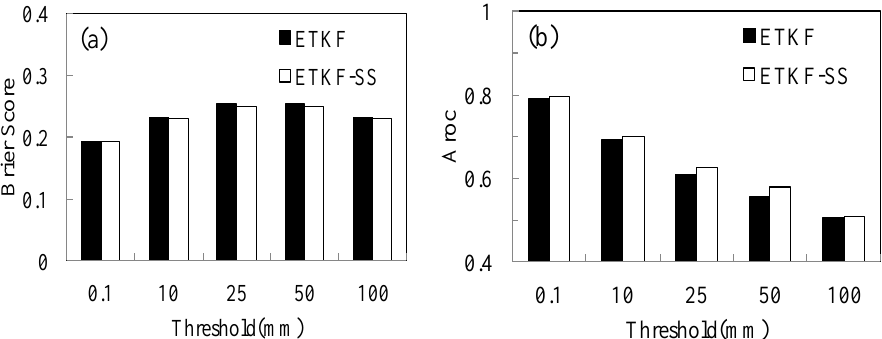
Figure 11. The score of the 24-h cumulative precipitation on 31 July 2015; ( a ) Brier score and ( b ) AROC.